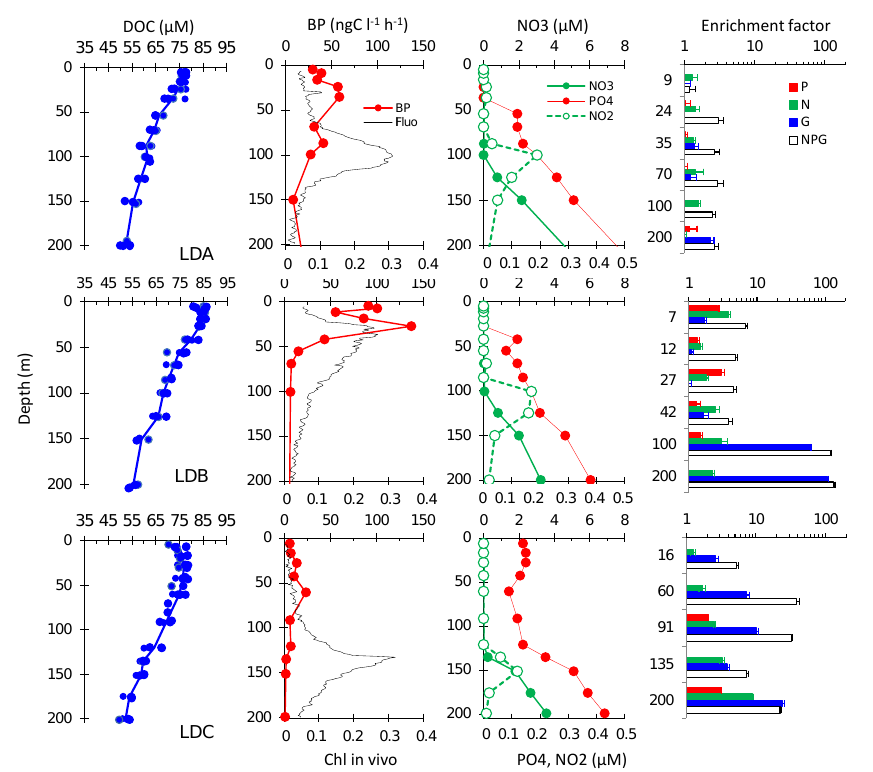
Figure 9. Enrichment experiments. Initial conditions illustrated by vertical profiles (0–200m) of in vivo fluorescence, BP, nutrients (nitrate (NO 3 ), nitrite (NO 2 ), and phosphate (DIP)) and enrichment factors sampled from the 12:00 ctd cast on day 2 of occupation at each LD site. As DOC was not sampled on this cast, we showed the data from all the other casts at the corresponding LD site (circles) and the average profile (line). Enrichment factors are the ratio of BP after a given enrichment (DIP: P in red; nitrate + ammonium: N in green; glucose: G in blue; and all components: NPG in black) compared to the unamended control, both measured after 24h incubations. The error bar is standard deviation within triplicates, and a bar is shown only if BP is significantly greater than in the control (Mann–Whitney test, p< 0 . 05).